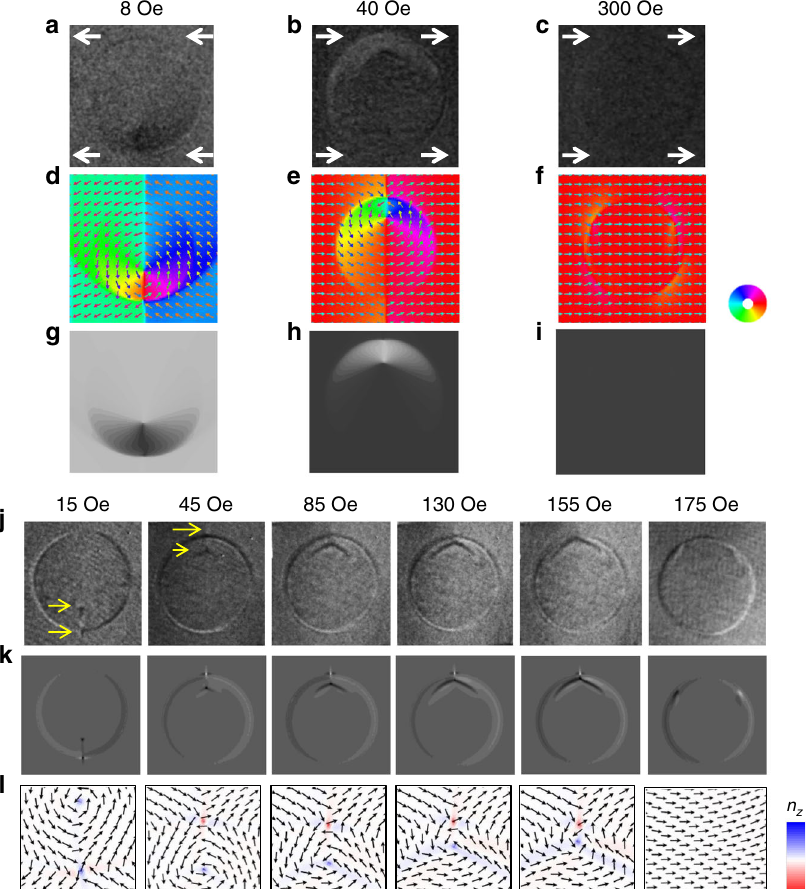
Fig. 4 Magnetization process of a meron pair in the Py fi lm. a – i In-plane magnetic contrast at three different states of H < + H c ( a , d , g ), + H c< H < + H s ( b , e , h ), and H > + H s ( c , f , i ) in the magnetization process. a , b , c The experimental results. The white arrows indicate the direction of surrounding Py magnetization. d , e , f Corresponding magnetization pro fi les obtained by simulation. g , h , i Corresponding thickness averaged x -component of the simulated magnetization pro fi le in the Py fi lm. j , k , l Out-of-plane magnetic contrast during the magnetization process. At the end of region (1) (e.g., the 15 Oe image in the fi gures), a meron pair is nucleated at the bottom edge of the disk area; after passing region (2) (e.g., the 45 Oe image in the fi gures), a new pair forms at the top edge; further increasing the magnetic fi eld makes the distance between the two cores gradually reducing from ~300 nm toward zero (e.g., the 85 – 155 Oe images in the fi gures), and fi nally the meron pair is annihilated at the end of region (3) (e.g., the 175 Oe image in the fi gures). j The experimental images, where the yellow arrows in the fi rst two images indicate the core position of vortices and antivortices; k thickness averaged z - component of the magnetization in the Py fi lm in a simulation with the same fi eld sequence; l zoomed in view of the magnetization pro fi le close to the meron pairs at the bottom surface of Py from simulations, where the in-plane magnetization pro fi le is plotted by arrows and the out-of-plane component of the magnetization is represented by the